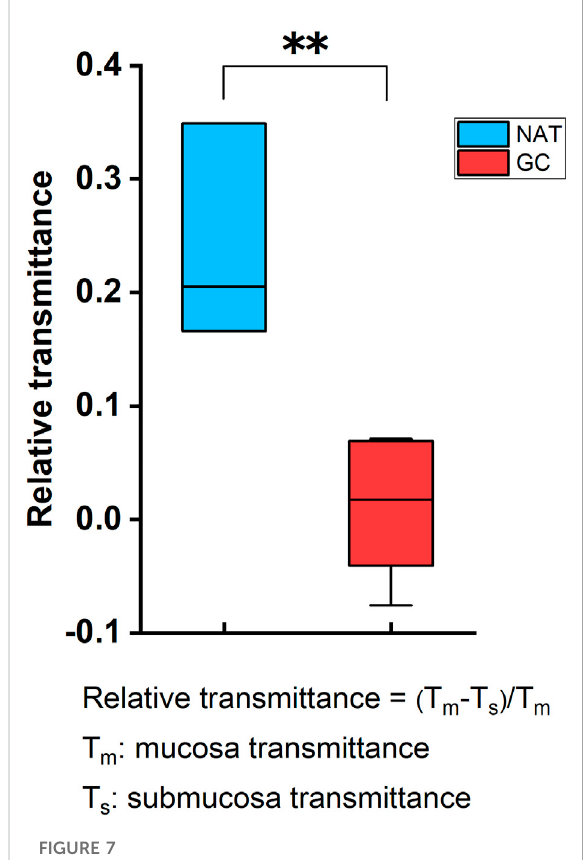
FIGURE 7 The difference of RT between NAT and GC tissue. The transmittancedifference between mucosa and submucosa in NAT was signi fi cantly higher than that in GC tissue. RT between submucosa and mucosa was de fi ned as RT = (T m -T s )/T m , where T m was averaged transmittance of mucosa and T s was averaged transmittance of submucosa. **: p <